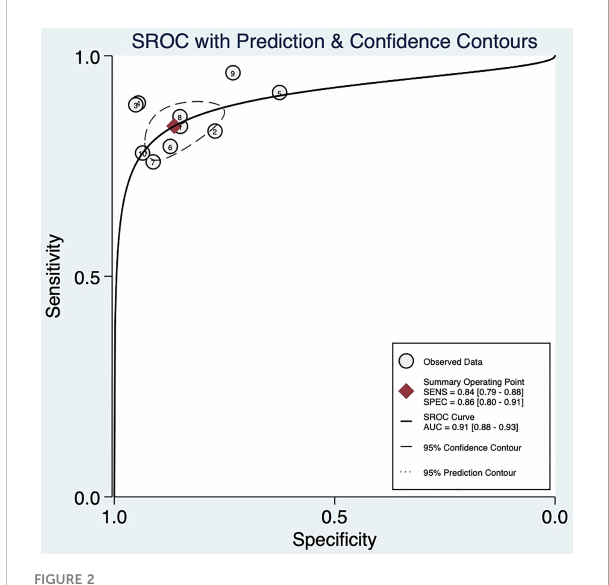
FIGURE 2 SROC curve and 95% con fi dence region.